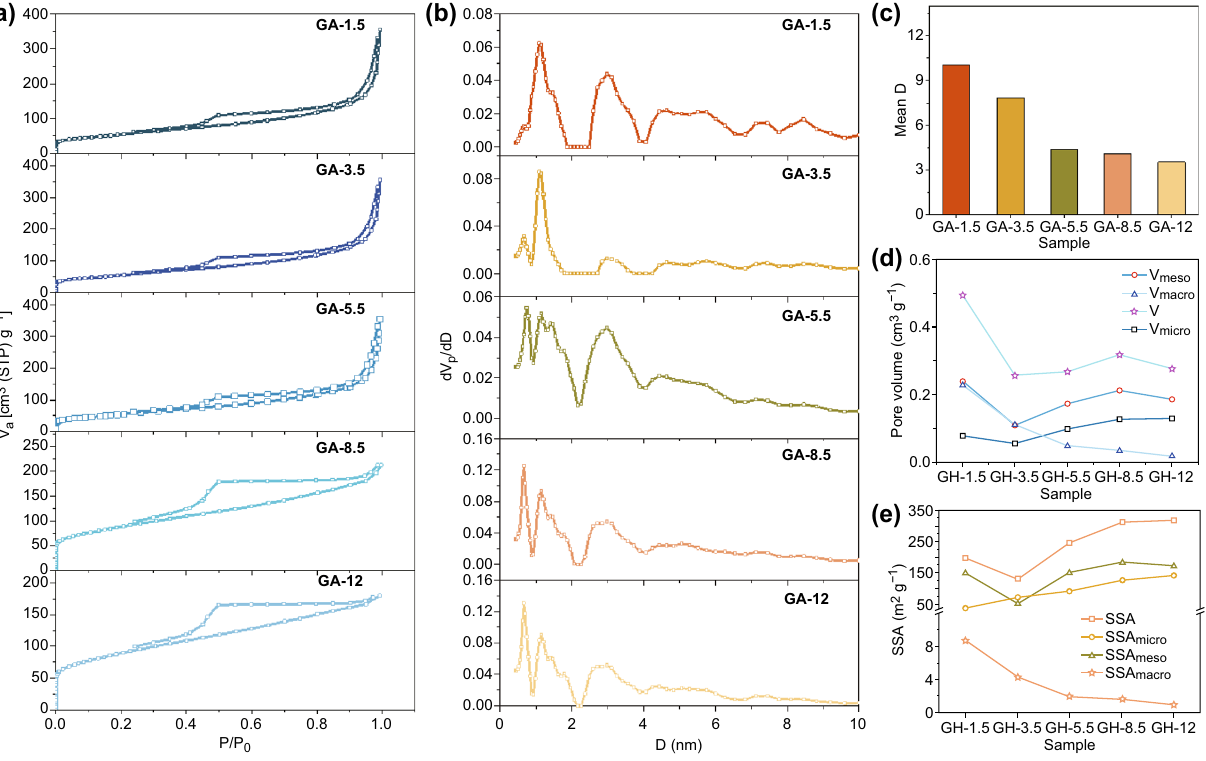
Fig. 2 a N 2 adsorption/desorption isotherms, b pore size distribution, c mean pore diameter, d pore volume, and e SSA of the GA